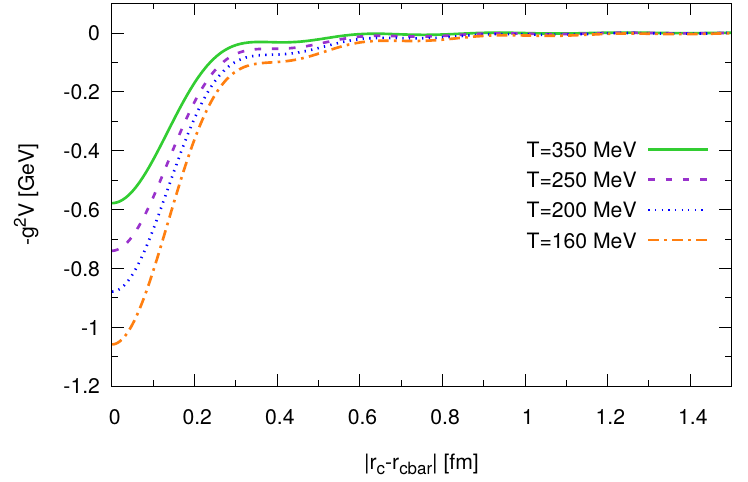
Figure 1. The charm-anti-charm-quark pair potential for different